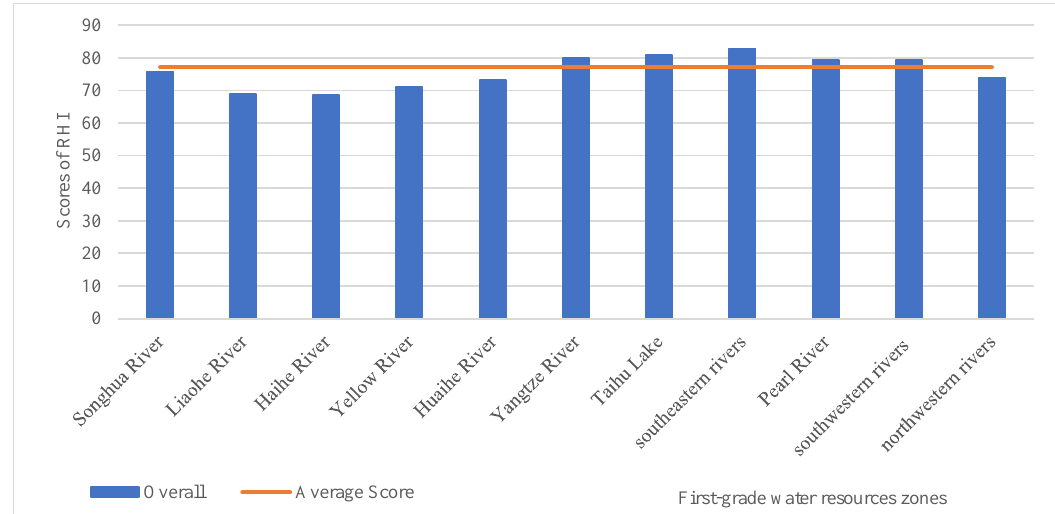
Figure 9. RHI evaluation results for China’s first -grade water resource zones.